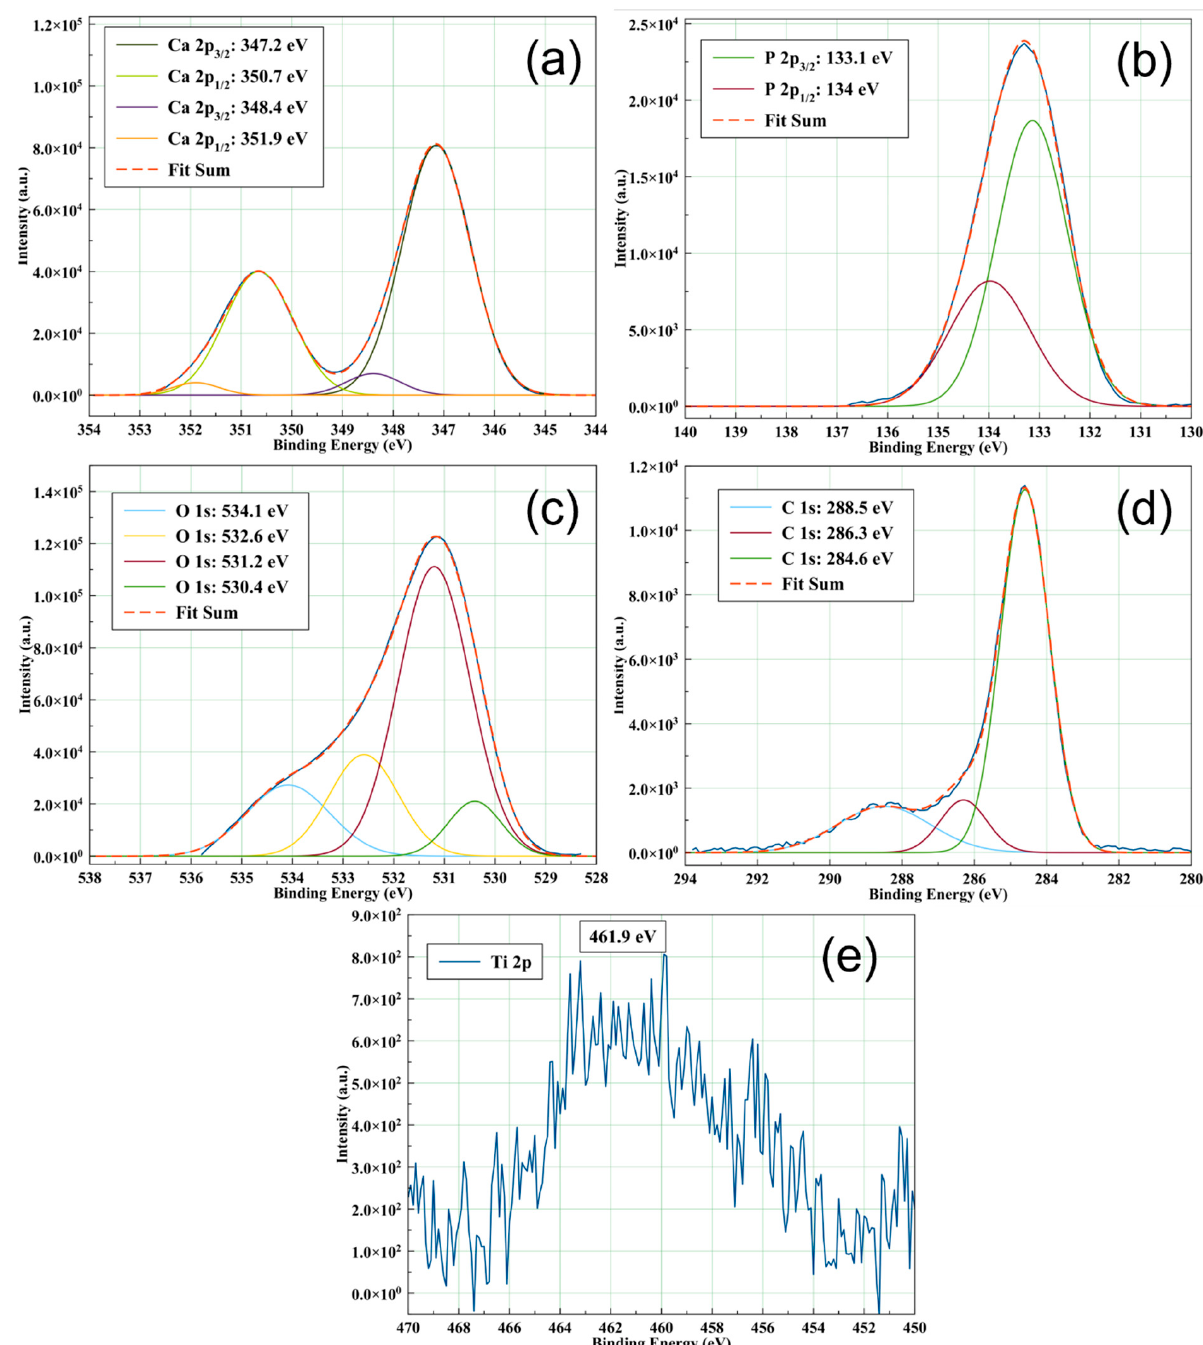
Figure 4. XPS high-resolution deconvoluted spectra of CaP_1 sample: ( a ) Ca 2p, ( b ) P 2p, ( c ) O 1s, and ( d ) C 1s and XPS high-resolution spectrum of ( e ) Ti 2p.